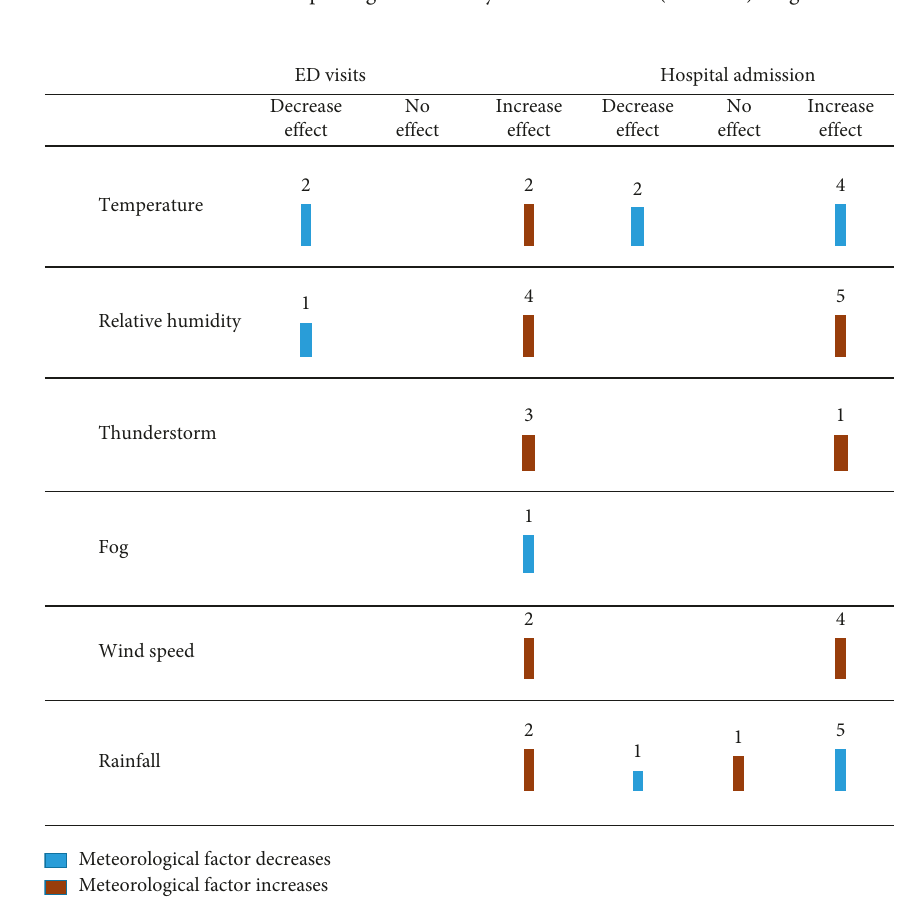
Figure 1: Preferred Reporting items for Systematic Reviews (PRISMA)